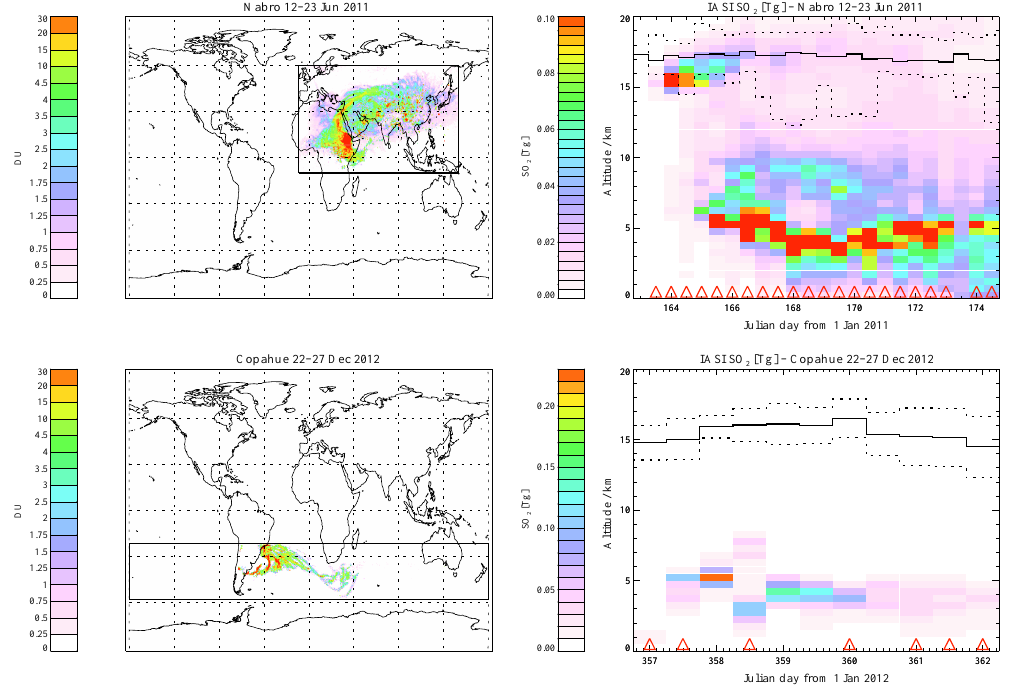
Figure 11. As for Fig. 8.